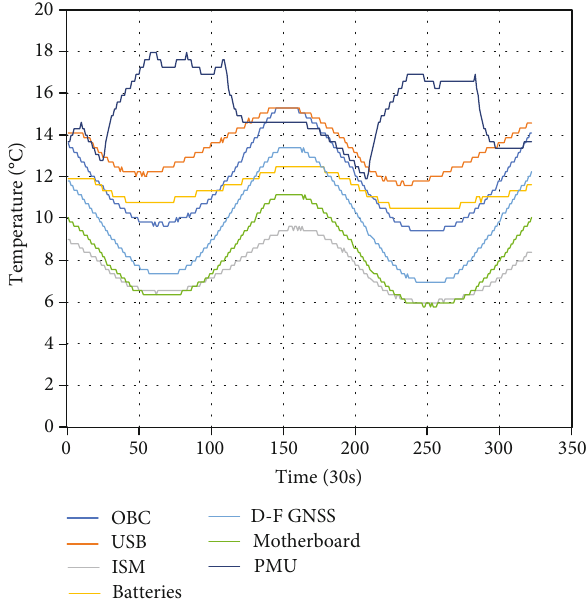
Figure 17: Temperatures of devices inside Q-SAT on 2021.2.10.